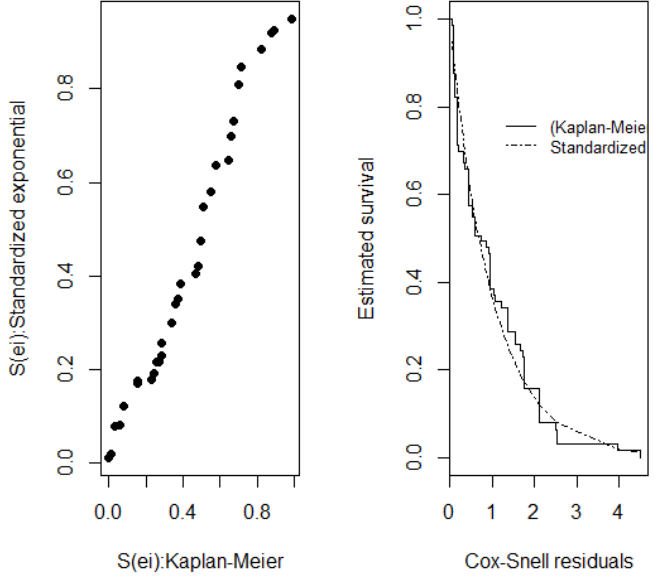
Figure 3. Cox-Snell residuals evaluating the overall final model fit.